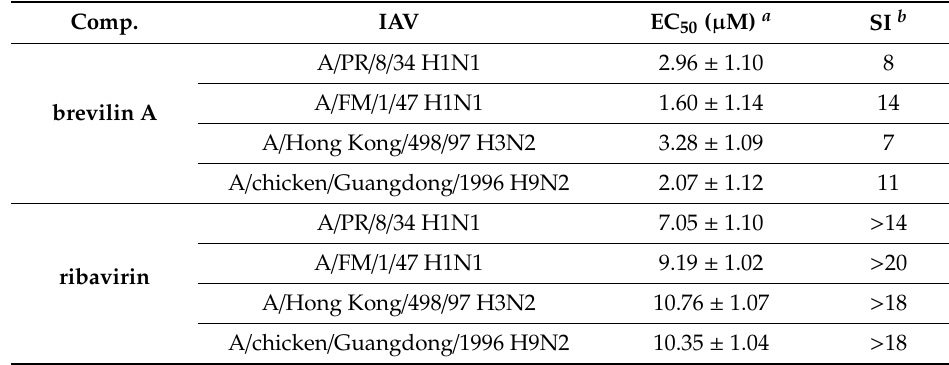
Table 1. Anti-IAV activities of brevilin